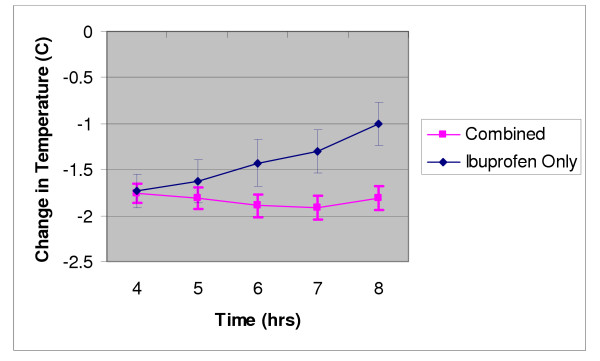
Mean (SE) change in temperature, from baseline, over time in the two treatment groups.